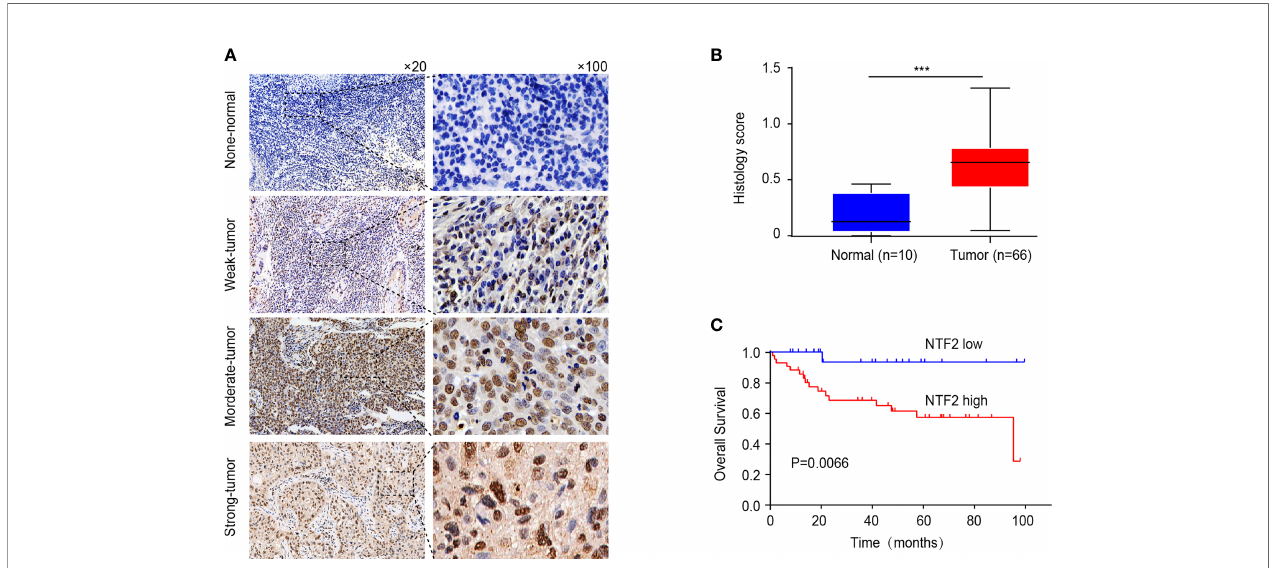
FIGURE 4 | Immunohistochemical evaluation of NTF2 as a prognostic marker. (A) Negative, weak, moderate, strong immunohistochemical staining of NTF2 was shown respectively in HNSCC and normal samples. (B) The H-scores of 66 HNSCC tissue were compared with those of 10 normal tissue. (C) Overall survival rate was compared between low and high expression group of NTF2 based on H-score. ***P < 0.001.